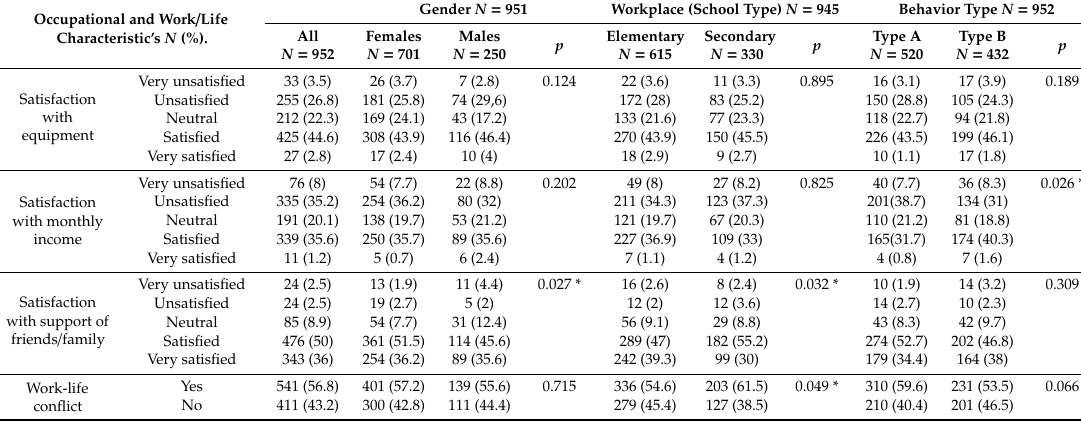
Table 2. Occupational and work–life characteristics in the total study sample stratified by gender, workplace, and behavior type Occupational and Work / Life Characteristic’s N (%).